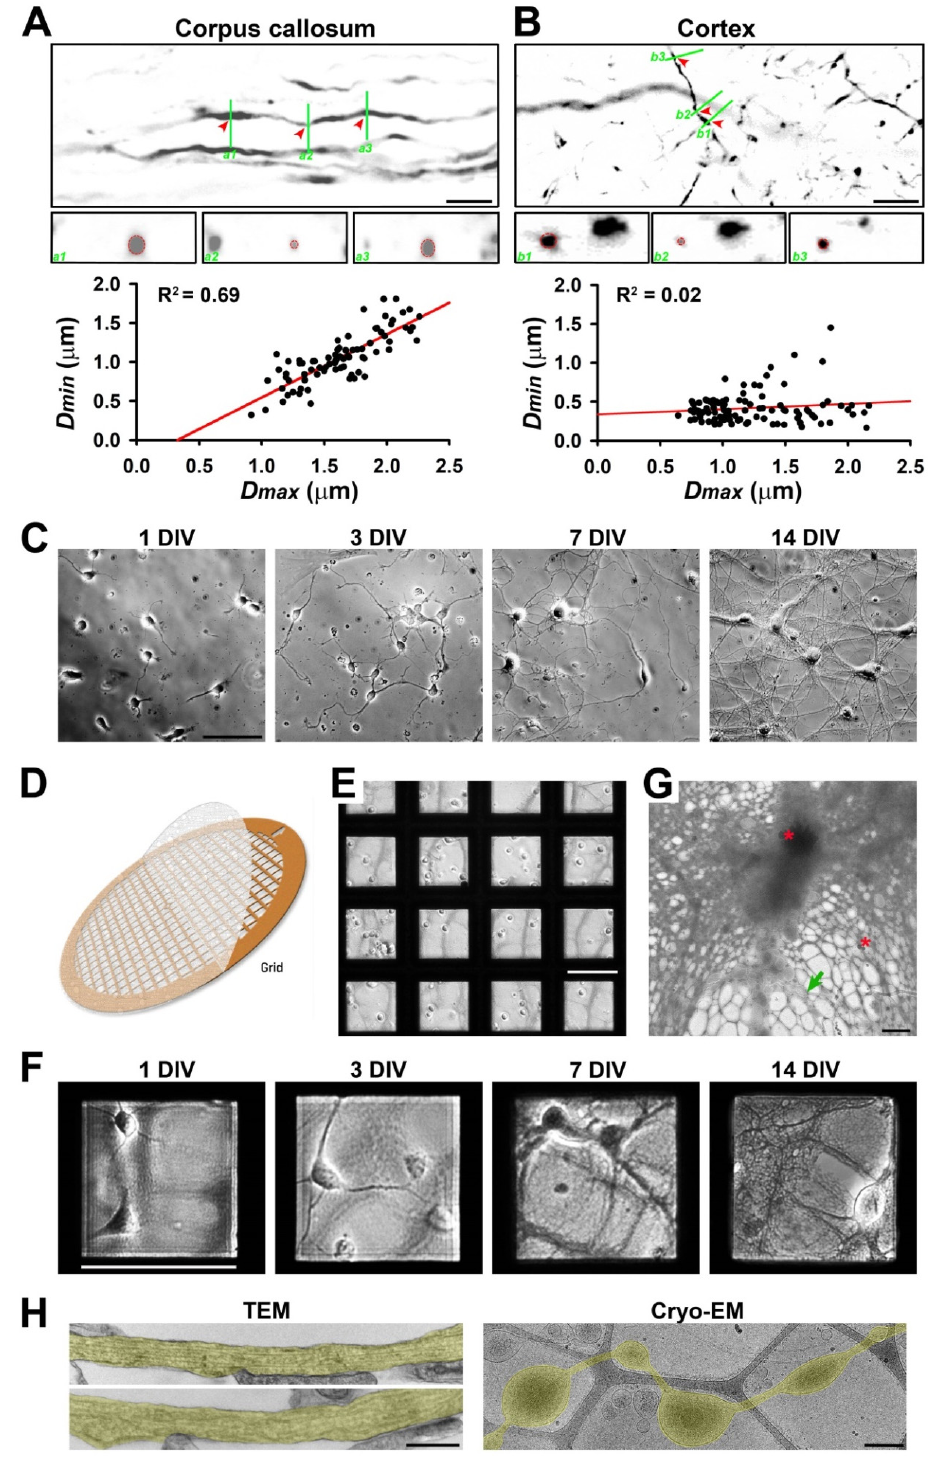
Figure 1. Diameter variation in individual axons correlates with the complexity of extracellular microenvironment. ( A ) Confocal images and 3D reconstruction of YFP+ (signals inverted in gray scale) axons in the corpus callosum of Thy1-YFP transgenic mice. In an XY focal plane (top), three green lines indicate the positions for three ZY focal planes (a1–a3, middle, enlarged by 2-fold) to show the diameters of three positions (indicated by red arrowheads) of a single axonal segment